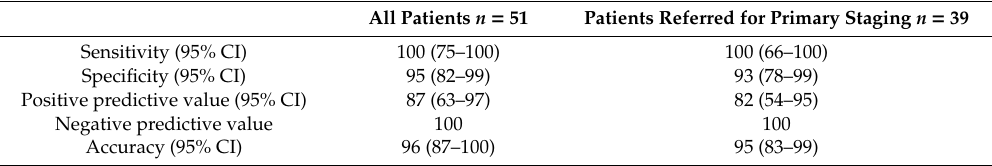
Table 3. Patient-based diagnostic performance of 68 Ga-PSMA PET / CT.